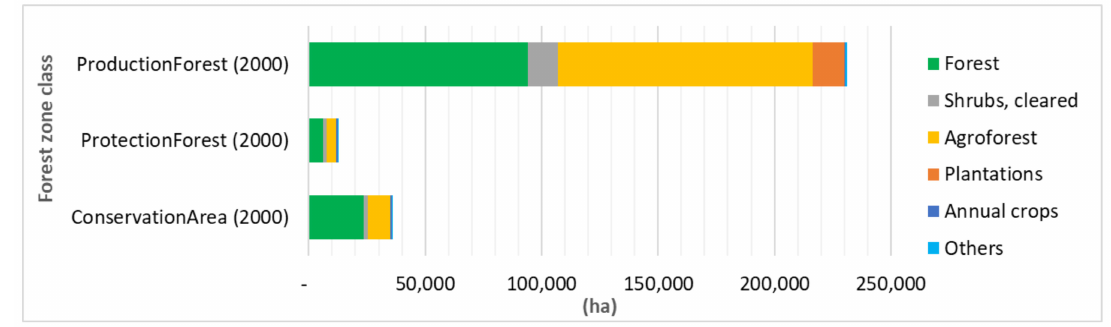
Figure 5. Past land cover types of agroforest in Forest-zone lands in Jambi (analyzed from [31]).